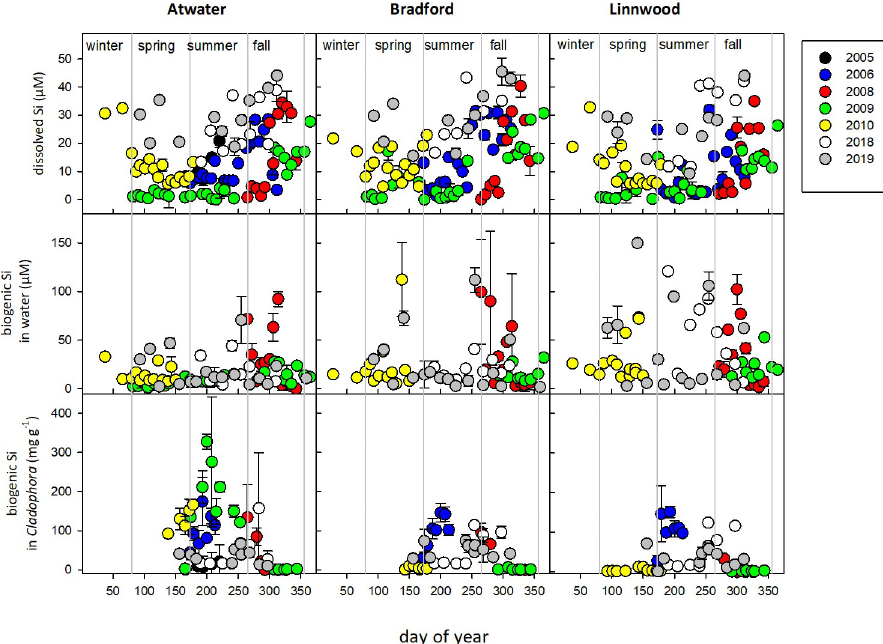
Fig 2. Dissolved silicate, suspended biogenic silica and biogenic silica in Cladophora assemblages in samples collected at 1 m depth at three Milwaukee-area beaches during 2005–2019.